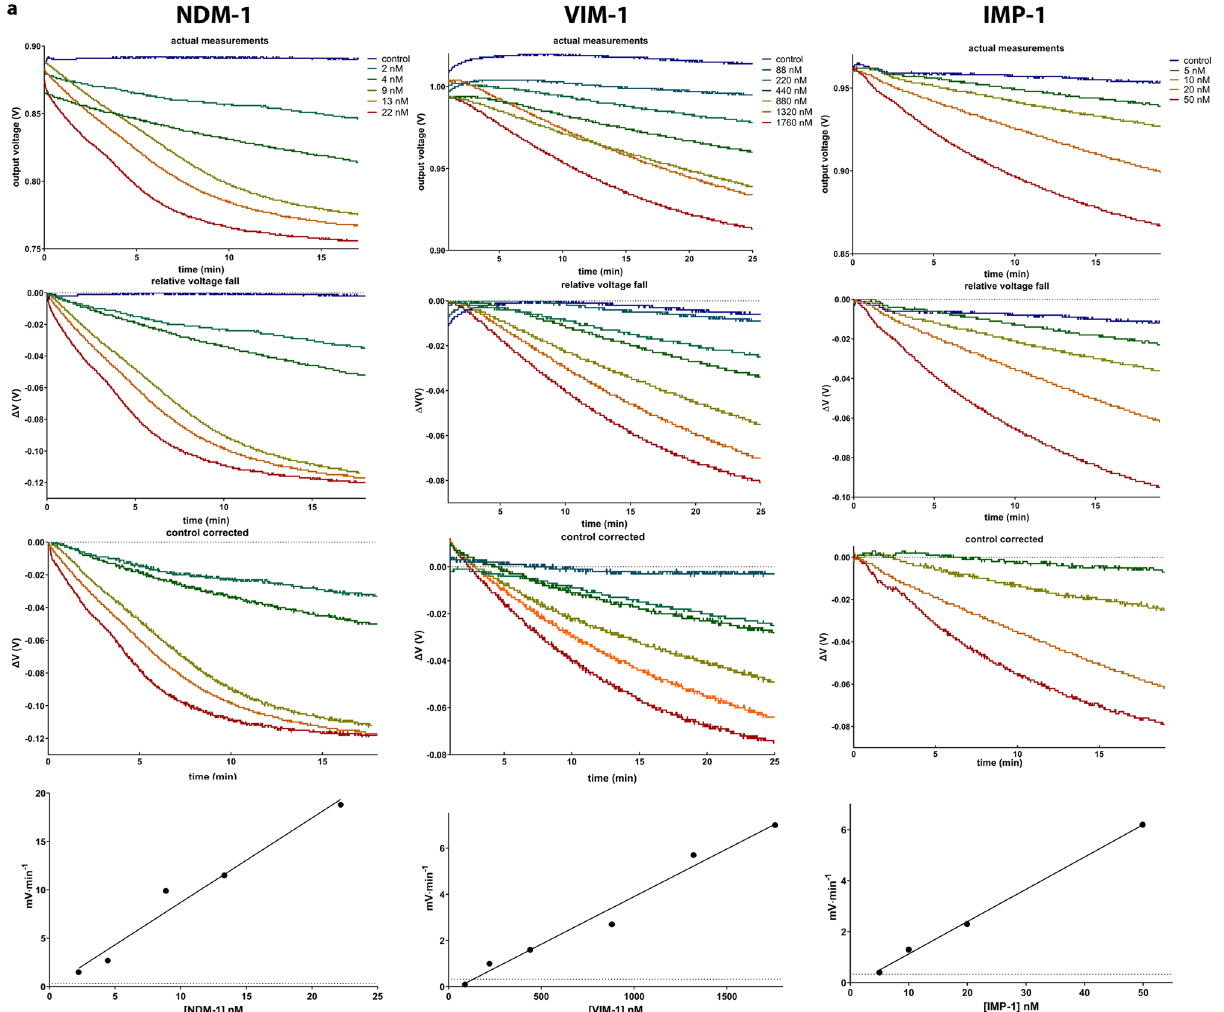
Figure 2. ISFET measurements using various quantities of MβL ( a ) and serine reactive (SbL) carbapenemase ( b ) containing crude protein extracts. The enzyme concentration in each preparation was estimated through spectrophotometric measurement of imipenem hydrolysis and the Michaelis–Menten equation using the published steady-state constants. Graphs of the actual measurements, of relative voltage changes and of control corrected curves are shown. For the linear phase of each corrected curve the rate of voltage change was determined and plotted against the enzyme quantity (lower graphs). The detection threshold was set to − 0.33 mV/min and the enzyme concentration required to reach this limit was estimated through linear